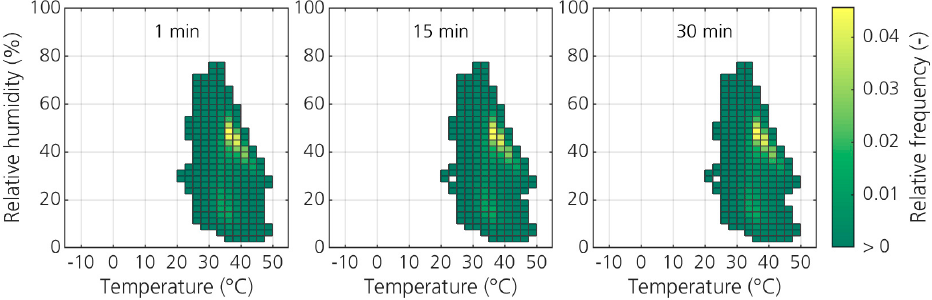
Figure 13. Effect of the sampling interval on the distribution of temperature and relative humidity measured inside the converter cabinet of a wind turbine (here: WT3).